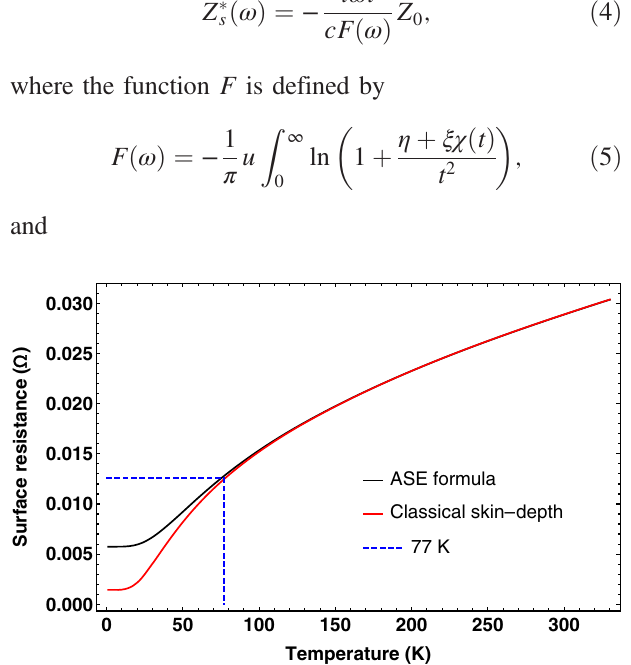
FIG. 1. A plot of the surface resistance for copper with RRR ¼ 400 versus temperature at 11.424 GHz. At low temperatures, the surface resistance, predicted by ASE, saturates to higher values than the ones calculated from the classical skin depth. Operating of 2.25 compared to 300